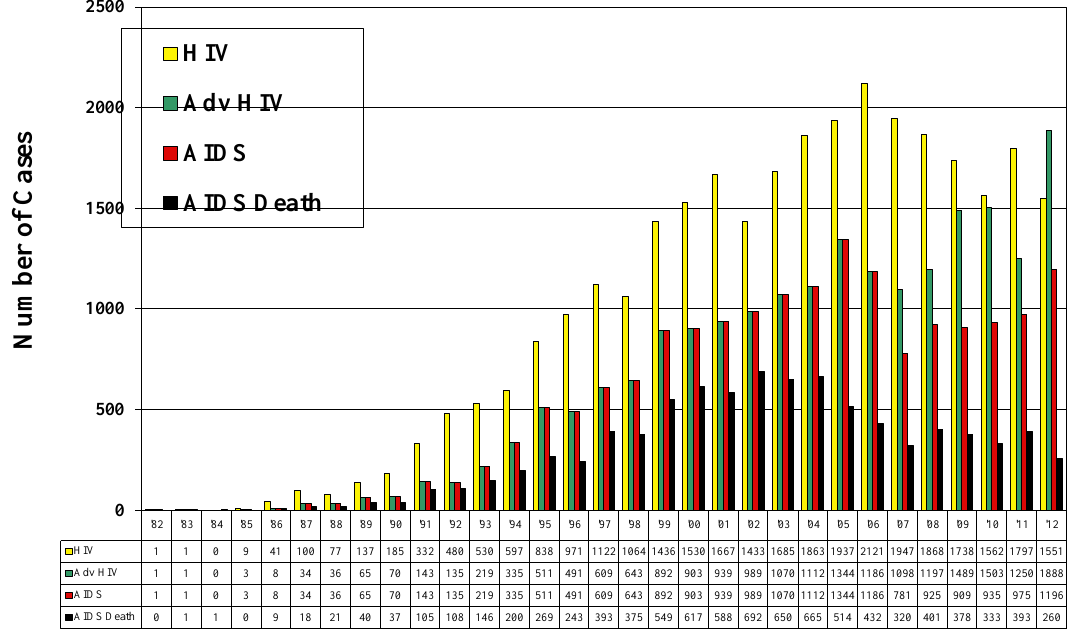
Figure 2: Reported cases and deaths annually in Jamaica, 1982-2012 Modes of